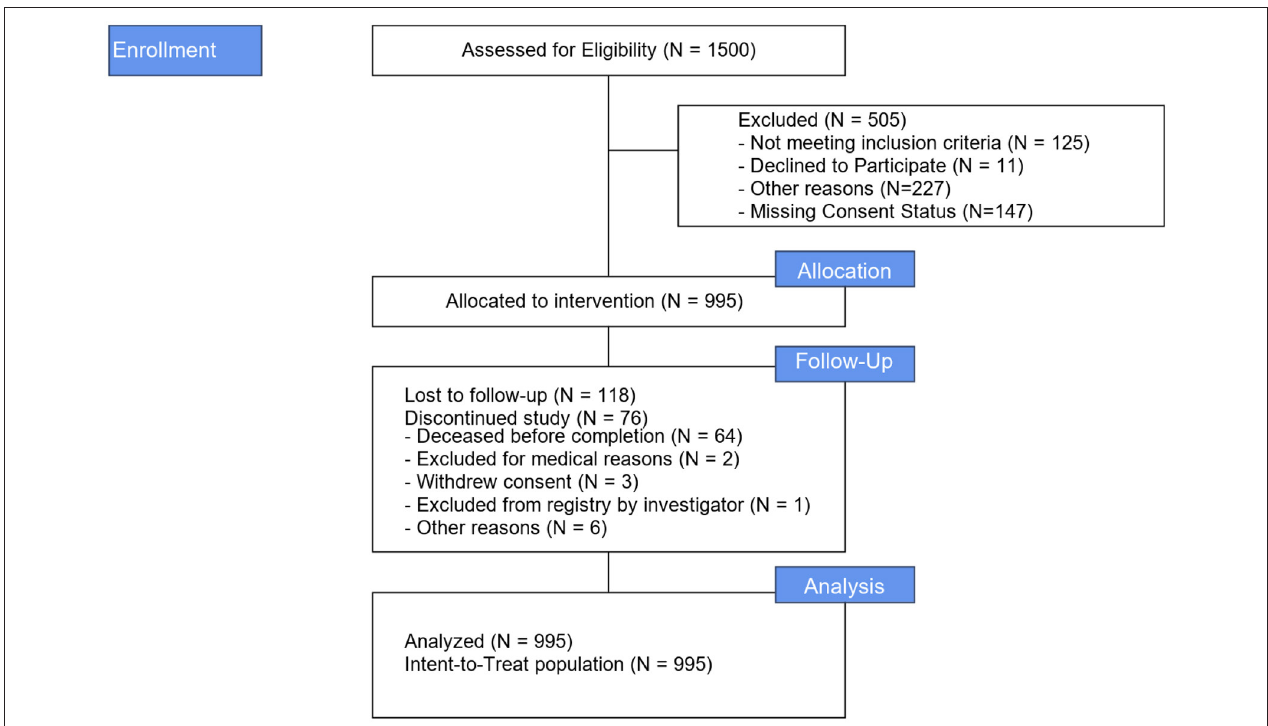
FIGURE 1 | Study flow